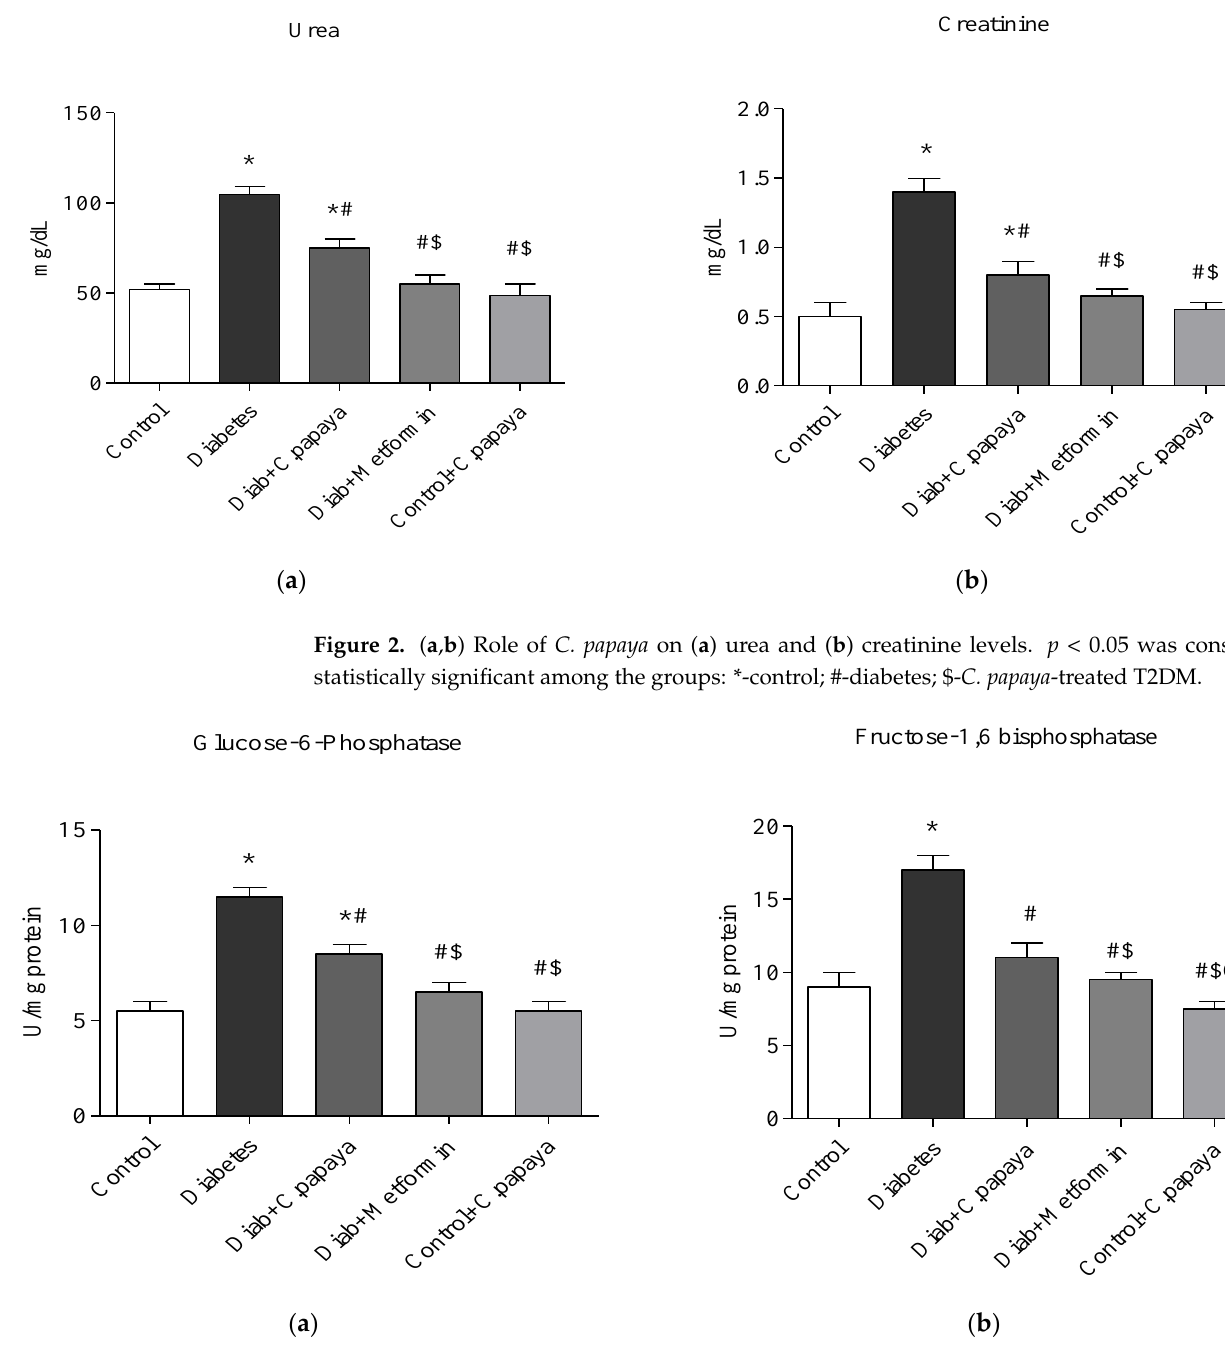
Figure 1. ( a , b ) Effect of C. papaya on ( a ) ALT and ( b ) AST levels. p < 0.05 was considered statistically significant among the groups: *-control; #-diabetes; $- C. papaya -treated T2DM.